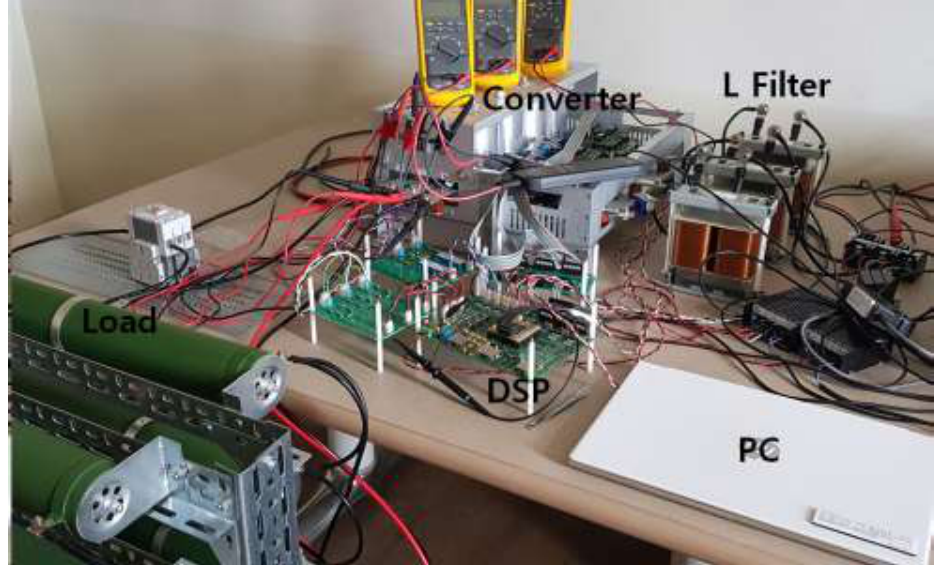
Figure 8. Photograph of the experimental test.